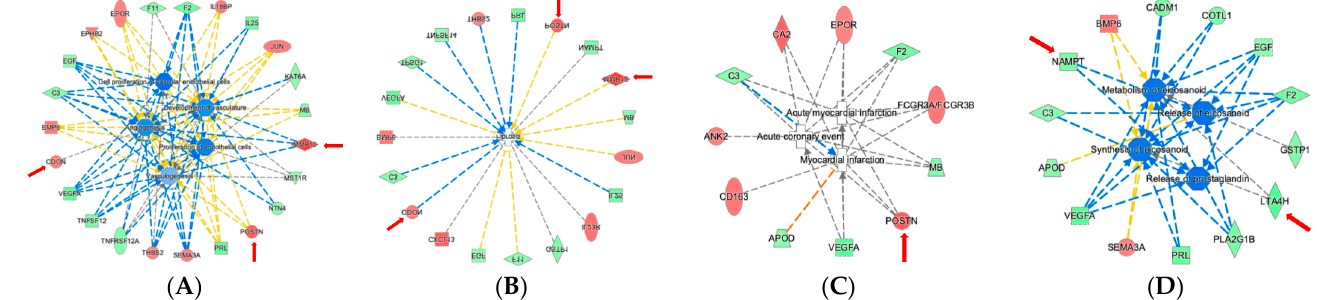
Figure 8. Biological functions linked to altered plasma protein profiles after surgical myectomy with predicted protein interactions. ( A ). Biological network linked to vascular function. ( B ). Biological network linked to fibrosis. ( C ). Biological network linked to myocardial injury. ( D ). Biological network linked to eicosanoid metabolism. Red indicates upregulation and green denotes downregulation in ‘post’. Proteins are coded by shape; square—cytokine, vertical rhombus—enzyme, horizontal rhombus—peptidase, trapezoid—transporter, ellipse—transmembrane receptor, and circle—other. Links are color-coded as red—leads to activation, blue—leads to inhibition, yellow—findings inconsistent with state of downstream protein, and black—effect not predicted. Red arrows indicate proteins of particular interest and